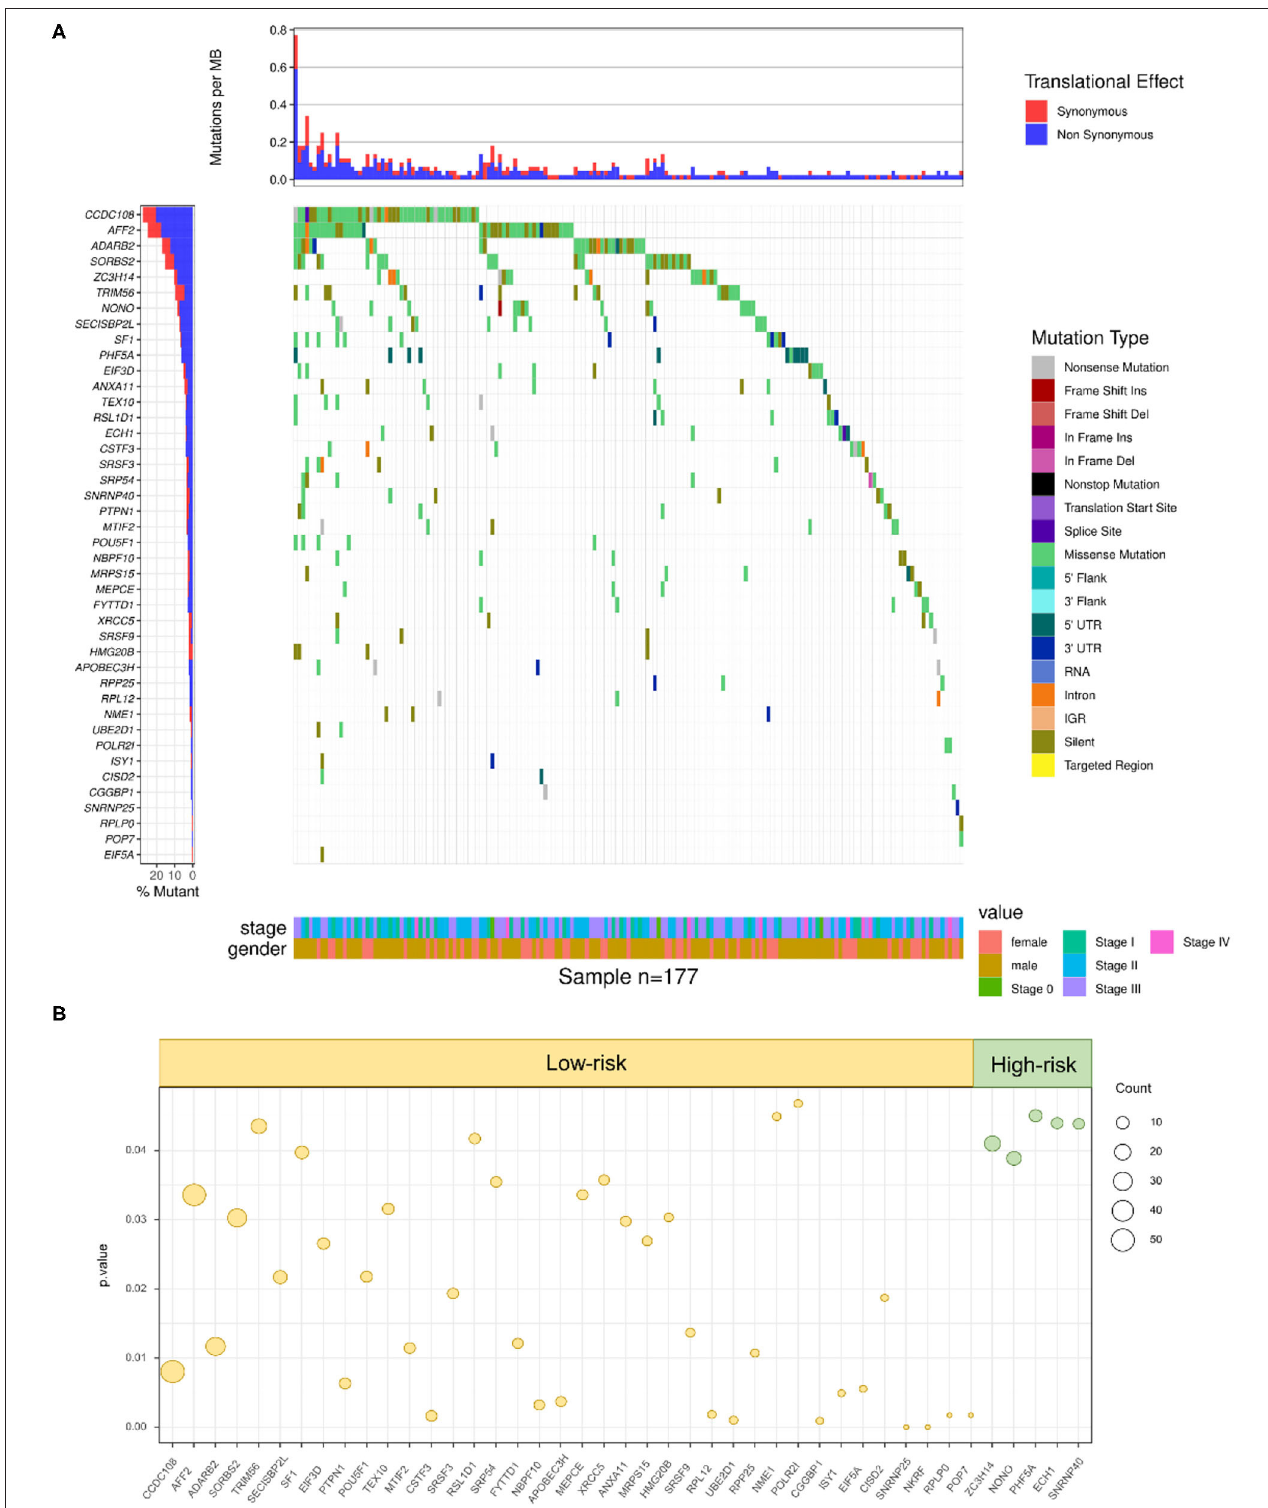
FIGURE 4 | RBP mutations correlated with SKCM prognosis. (A) A total of 43 RBPs were demonstrated to carry prognosis-associated mutations (Kruskal–Wallis H test P -values < 0.05). The y-axis represents each RBP and sorted by mutation frequency. The x-axis stands for different SKCM samples. The color indicates different mutation type. The bar plot above represents the mutation frequency with synonymous (red) and non-synonymous (blue) translational effects of each sample . (B) High-risk factors (right panel) and low-risk factors (left panel) of prognosis-related RBP mutations. The circle size stands for count of samples with mutations.